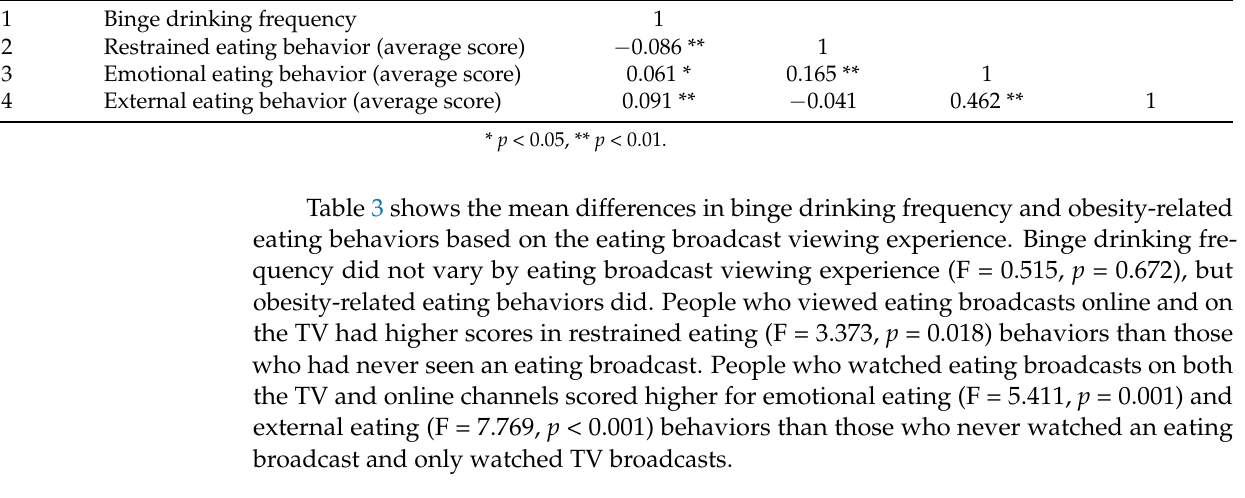
Table 3. Binge drinking frequency and obesity-related eating behaviors by eating broadcast viewing